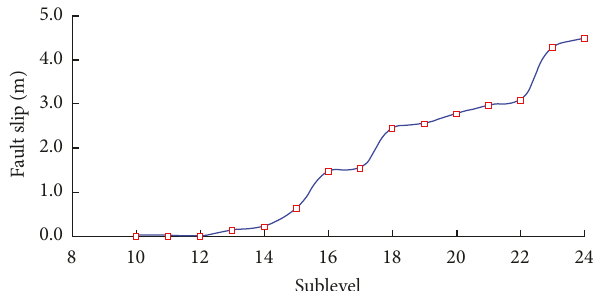
Figure 9: Relationship of slip amount of fault F2 with mining